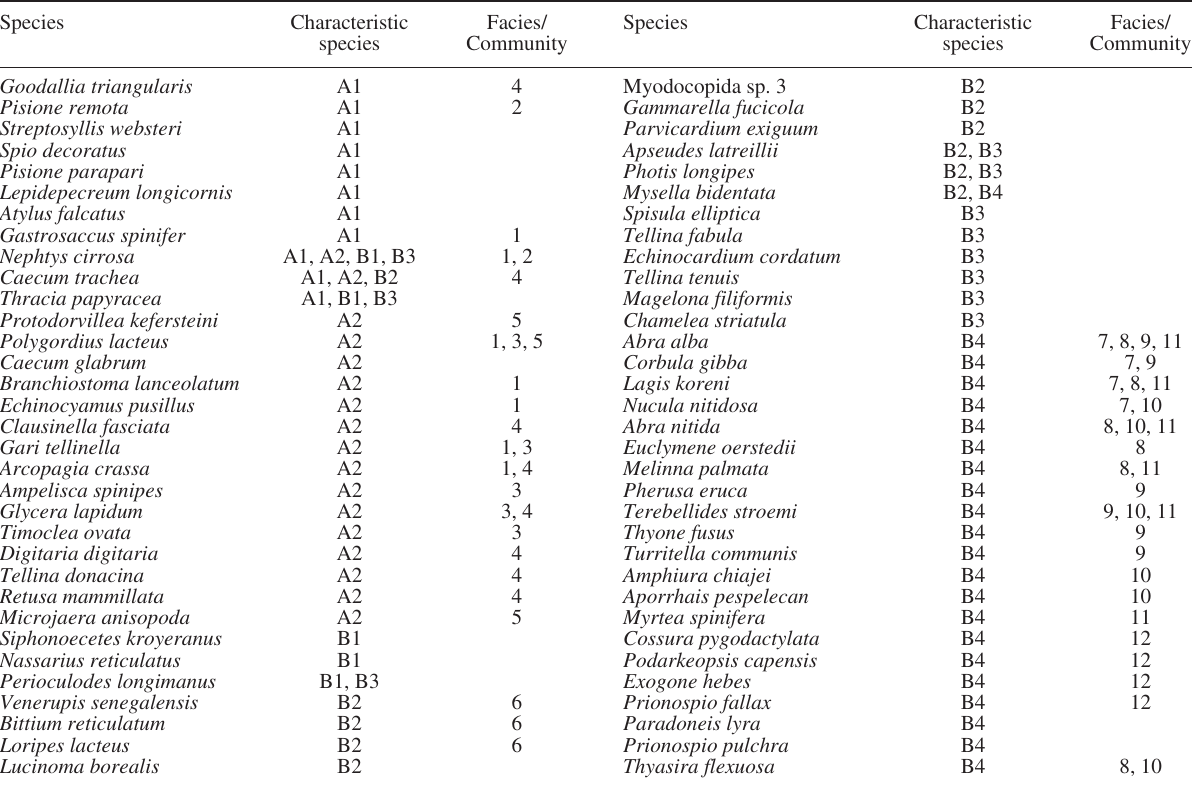
Table 5. – Characteristic species of the benthic assemblages of the Ría de Aldán determined by multivariate analyses; other assemblages in which those species were previously reported are also indicated. 1, Venus fasciata community (Glémarec, 1973); 2, Assemblage of Goniadel- la - Spisula (Salzwedel et al ., 1985); 3, Branchiostoma lanceolatum of gravel and sandy gravel facies (Toulemont, 1972); 4, Gravel and coarse sand assemblage (Troncoso and Urgorri, 1993); 5, Coarse-sand sediments (Besteiro et al ., 1987); 6, Facies of Zostera noltii (Olabarria et al ., 1998); 7, Syndosmya alba community (Petersen, 1918); 8, Other facies from Syndosmya alba community; 9, Heterogeneous sandy gravels and heterogeneous muddy sands (Chassé and Glémarec, 1976); 10, Boreo-mediterranean Amphiura community (Petersen, 1918); 11,